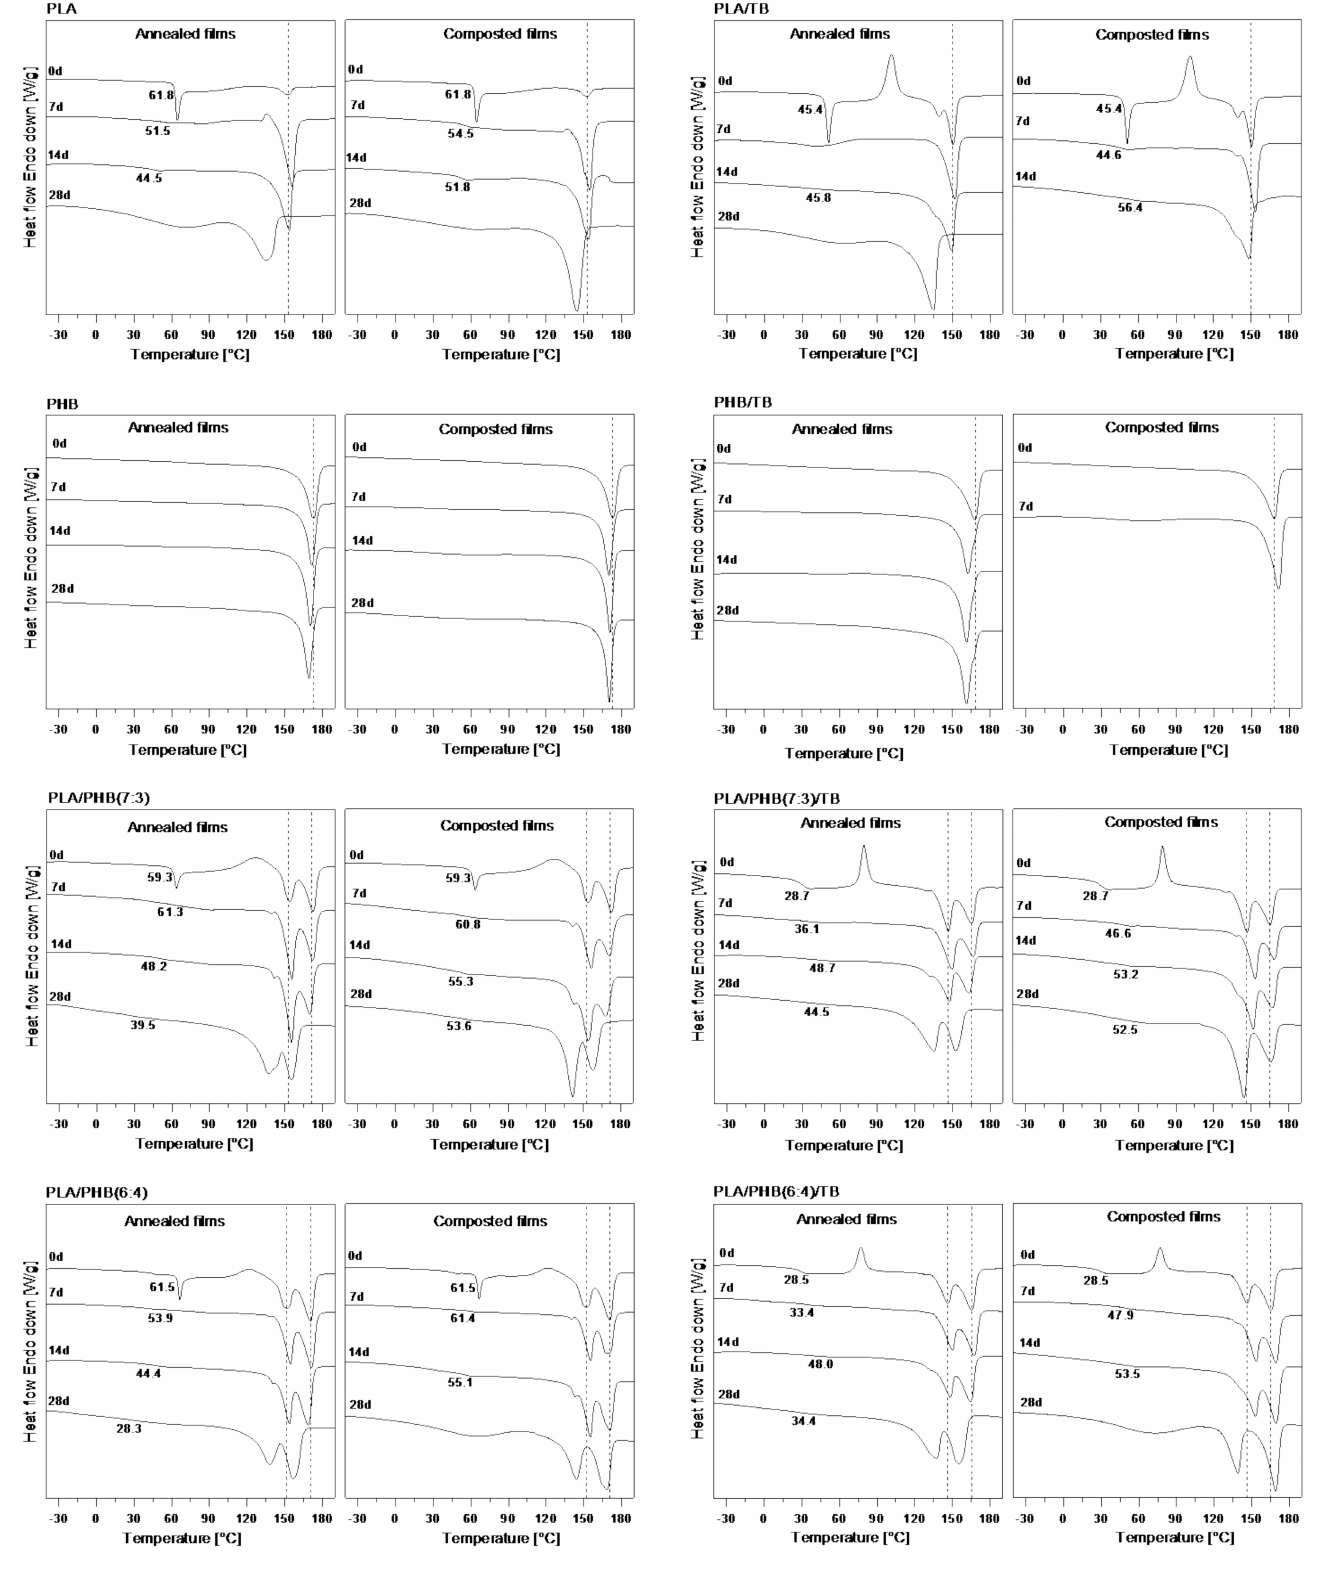
Figure 5. DSC first scans of PLA, PLA/TB, PHB, PHB/TB, PLA/PHB(7:3), PLA/PHB(7:3)/TB, PLA/PHB(6:4) and PLA/PHB(6:4)/TB films under annealing ( left ) and composting ( right ) conditions after 0, 7, 14, and 28 days. The numbers at each curve represent T g ( ◦ C) values of PLA. Heating rate: 20 ◦ C min − 1 under nitrogen